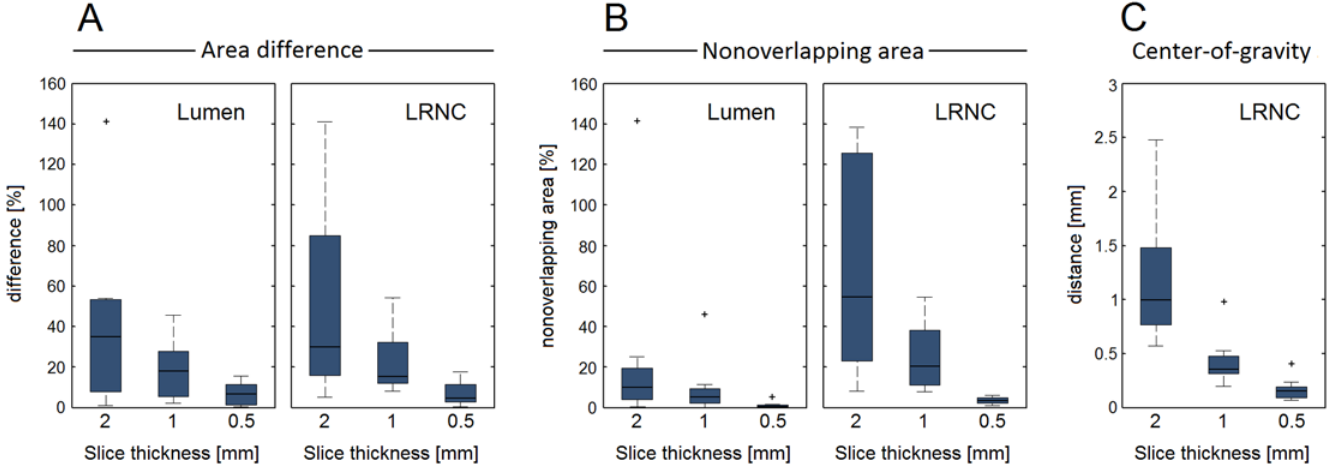
Fig 3. Three metrics quantify the axial geometrical variations in the ground truth models as a function of slice thickness. (A) Relative area difference between slice top and bottom cross sections for lumen and LRNC, (B) relative nonoverlapping area between slice top and bottom cross sections for lumen and LRNC, and (C) maximum in-plane shift of the center of gravity within the slice (C). Whiskers in the box plots represent maximum/minimum data points not considering outliers, which are marked by plus (+) symbols.